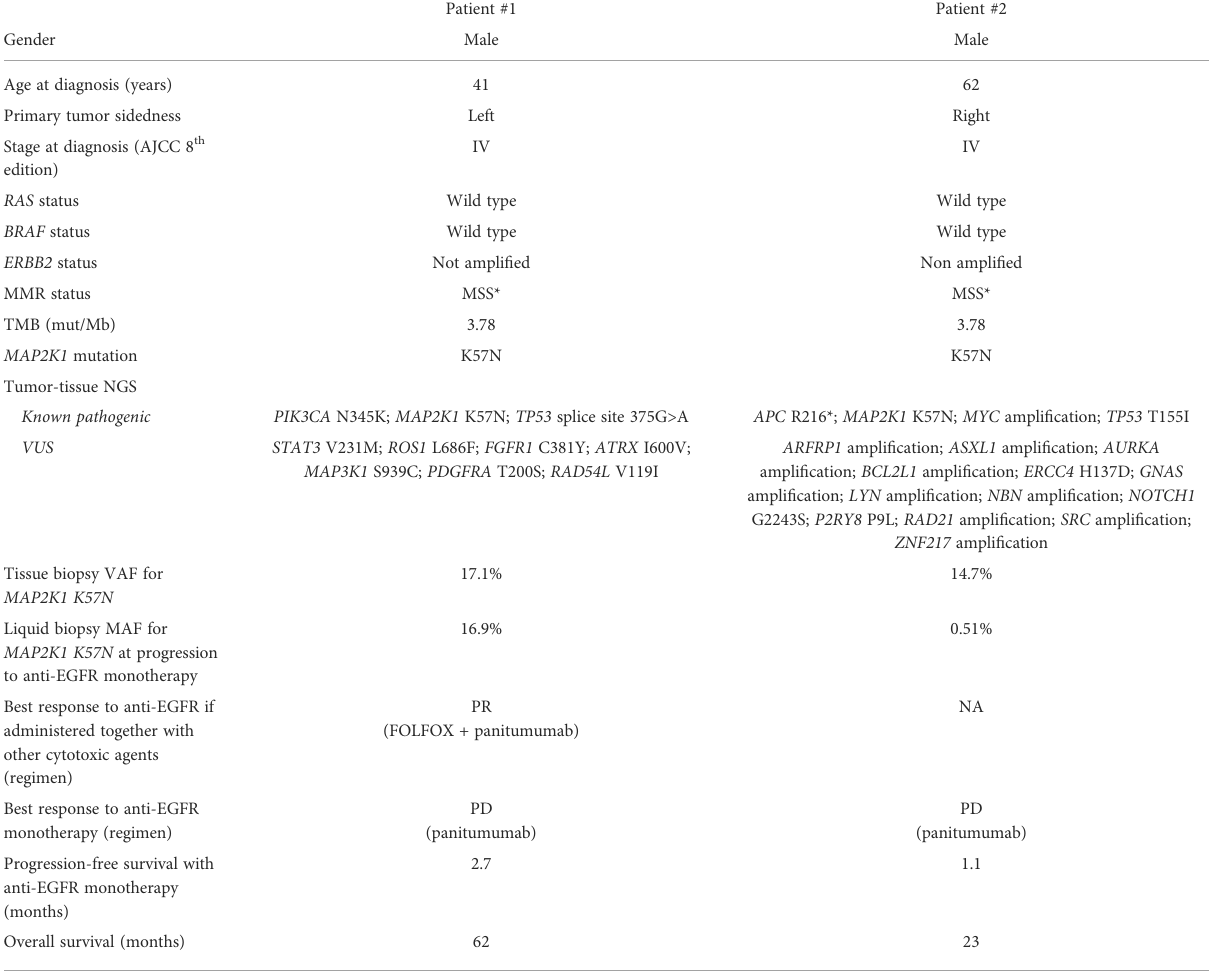
TABLE 1 Clinic-pathological features and anti-EGFR treatment outcome for patients #1 and